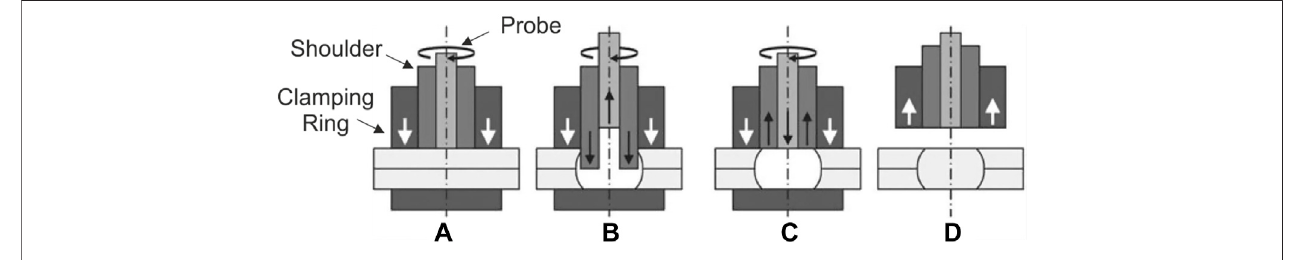
FIGURE1 | Illustration ofRFSSW stages for the shoulder-plunge variant: (A) clamping and tool rotation; (B) shoulder plunge and probe retraction; (C) tool back to surface level and (D) tool removal (Reprinted with permission from the publisher under a Creative Common license) (Campanelli et al., 2012).